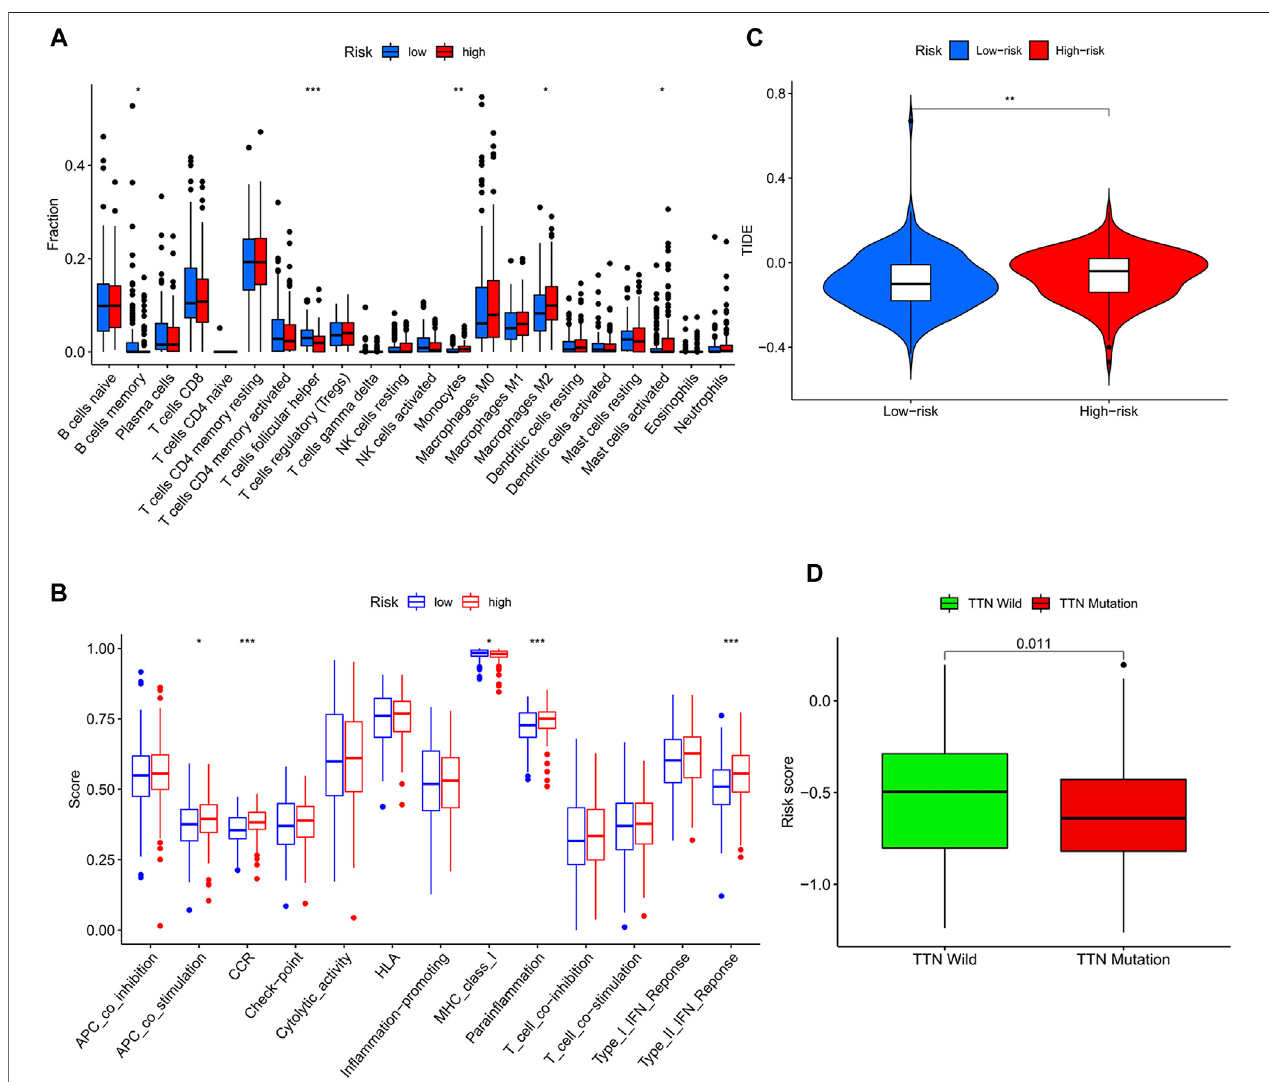
FIGURE 6 | Risk score-guided immunotherapy. (A) Box plot ofthe differential analysis ofimmune in fi ltration between the tworisk score groups. (B) Box plot of the differentialanalysisofimmune functionbetweentworiskscoregroups. (C) Violin plotoftheresponse toimmunotherapy betweenthetworiskfraction groupscalculated by the IDE algorithm. (D) Box plot of the differential analysis of the risk score between wild type and mutant type for the top 10 mutated genes in TCGA data.